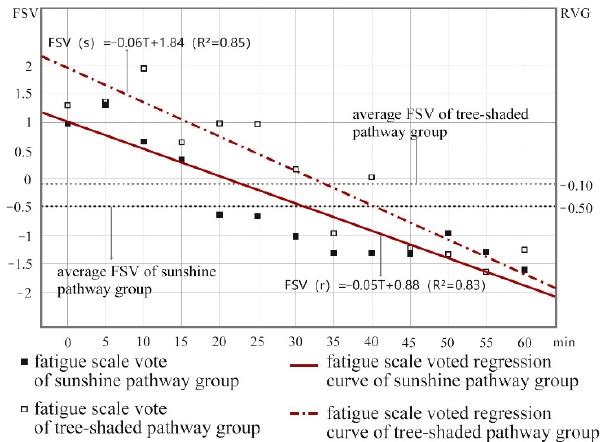
Figure 10. Fatigue scale votes of sunshine pathway group and tree-shade pathway group.